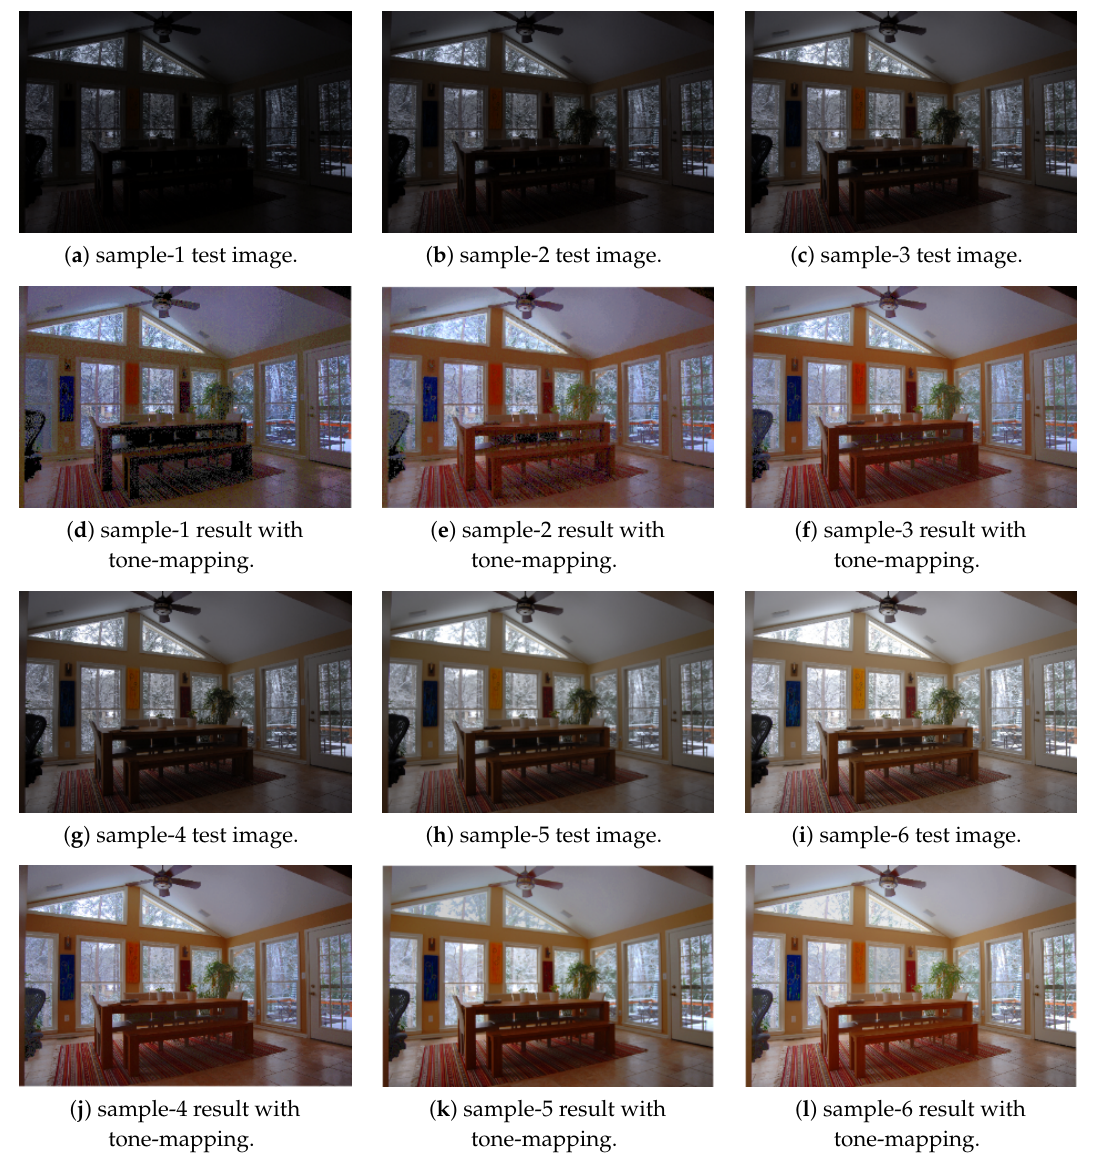
Figure 10. The results of Exposure Sample series images, ( a – c ), ( g – i ) are the input images, and ( d – f ), ( j – l ) are the outputs with